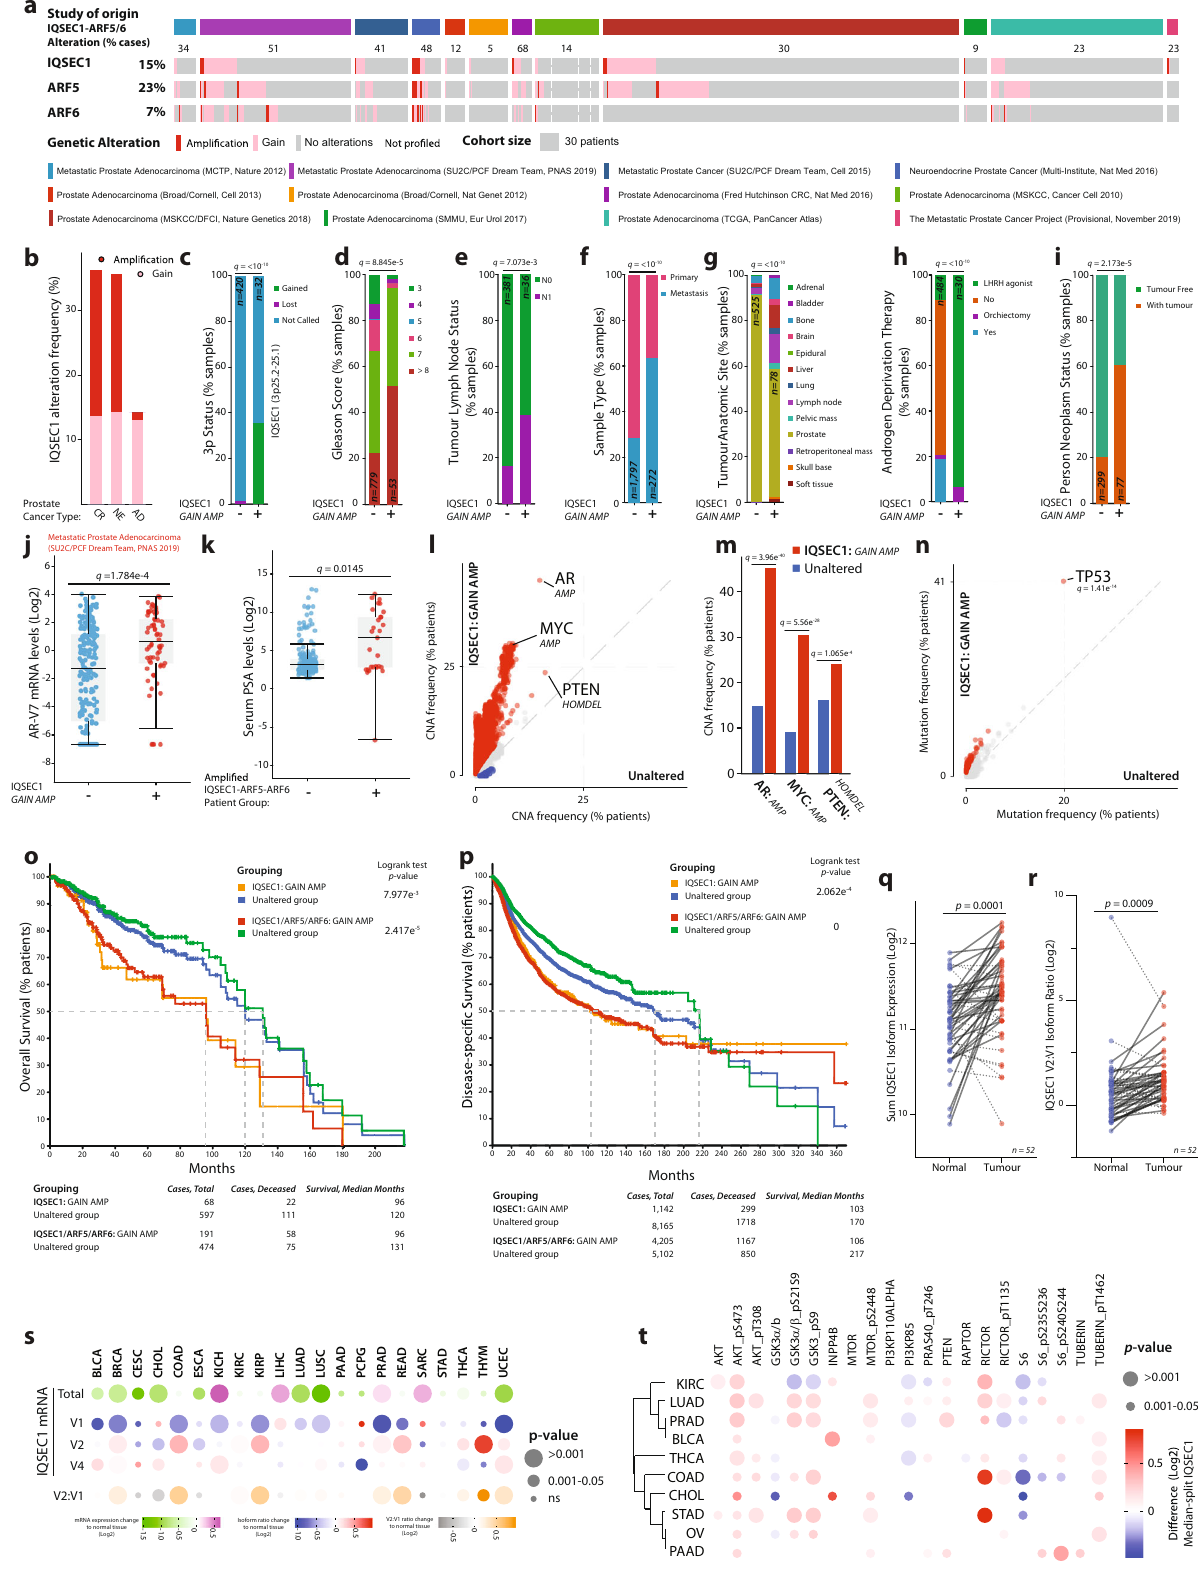
microscope were processed using the Zeiss proprietary ZEN 3.2 software, exported as TIFF fi les and processed in Fiji. Cells or acini on 96-well plates were imaged using an Opera Phenix ™ high content analysis system and where appropriate Harmony High-Content Imaging and Analysis Software (PerkinElmer, Version 4.6) was used to perform machine